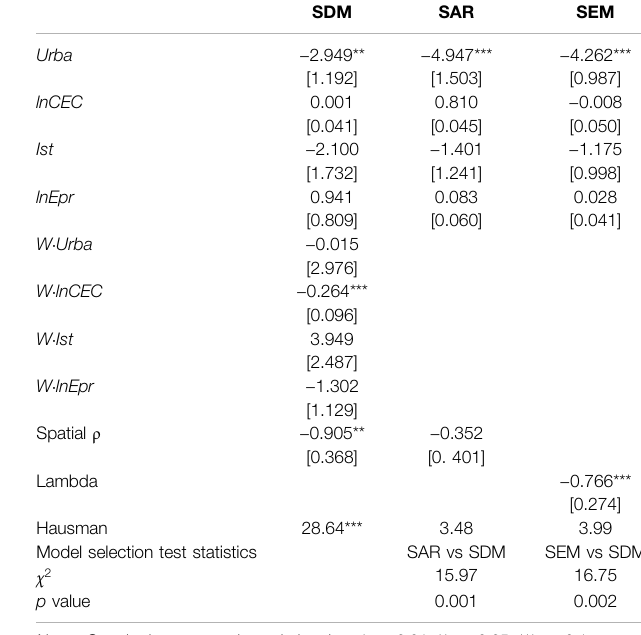
TABLE 8 | Spatial model estimation results of energy